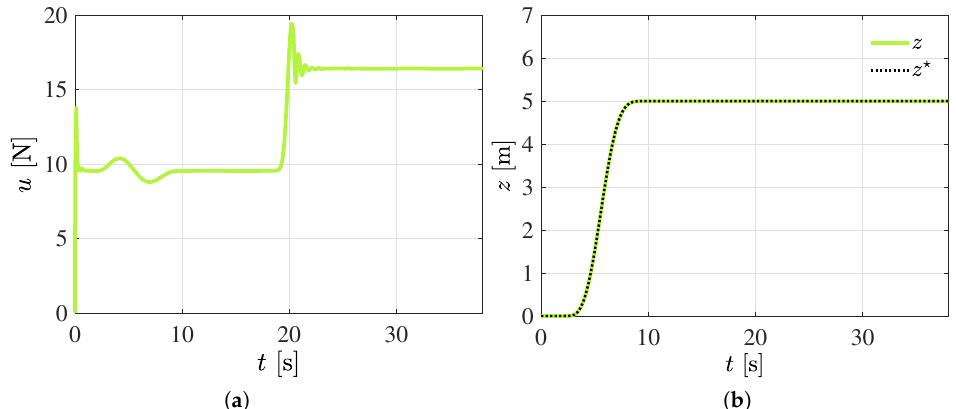
Figure 20. Reference tracking results for experiment 5.